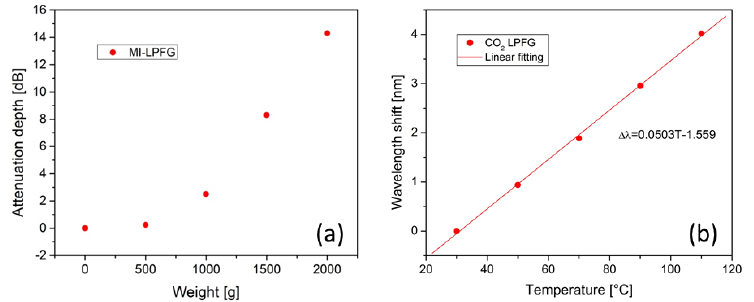
Figure 8. ( a ) Attenuation depth of MI-LPFG, and ( b ) wavelength shift of the CO 2 LPFG for the simultaneous measurement of transverse load and temperature, respectively.